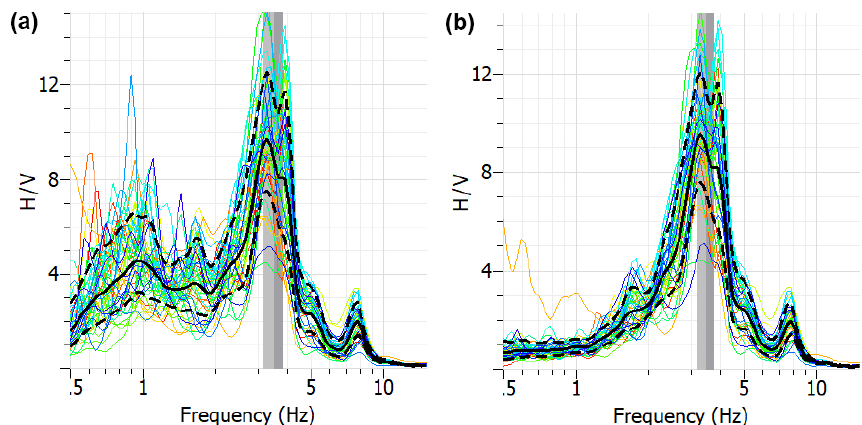
Figure 9. The obtained H / V spectral ratios of recorded data by (a) GeoBox and (b) MicDAC.